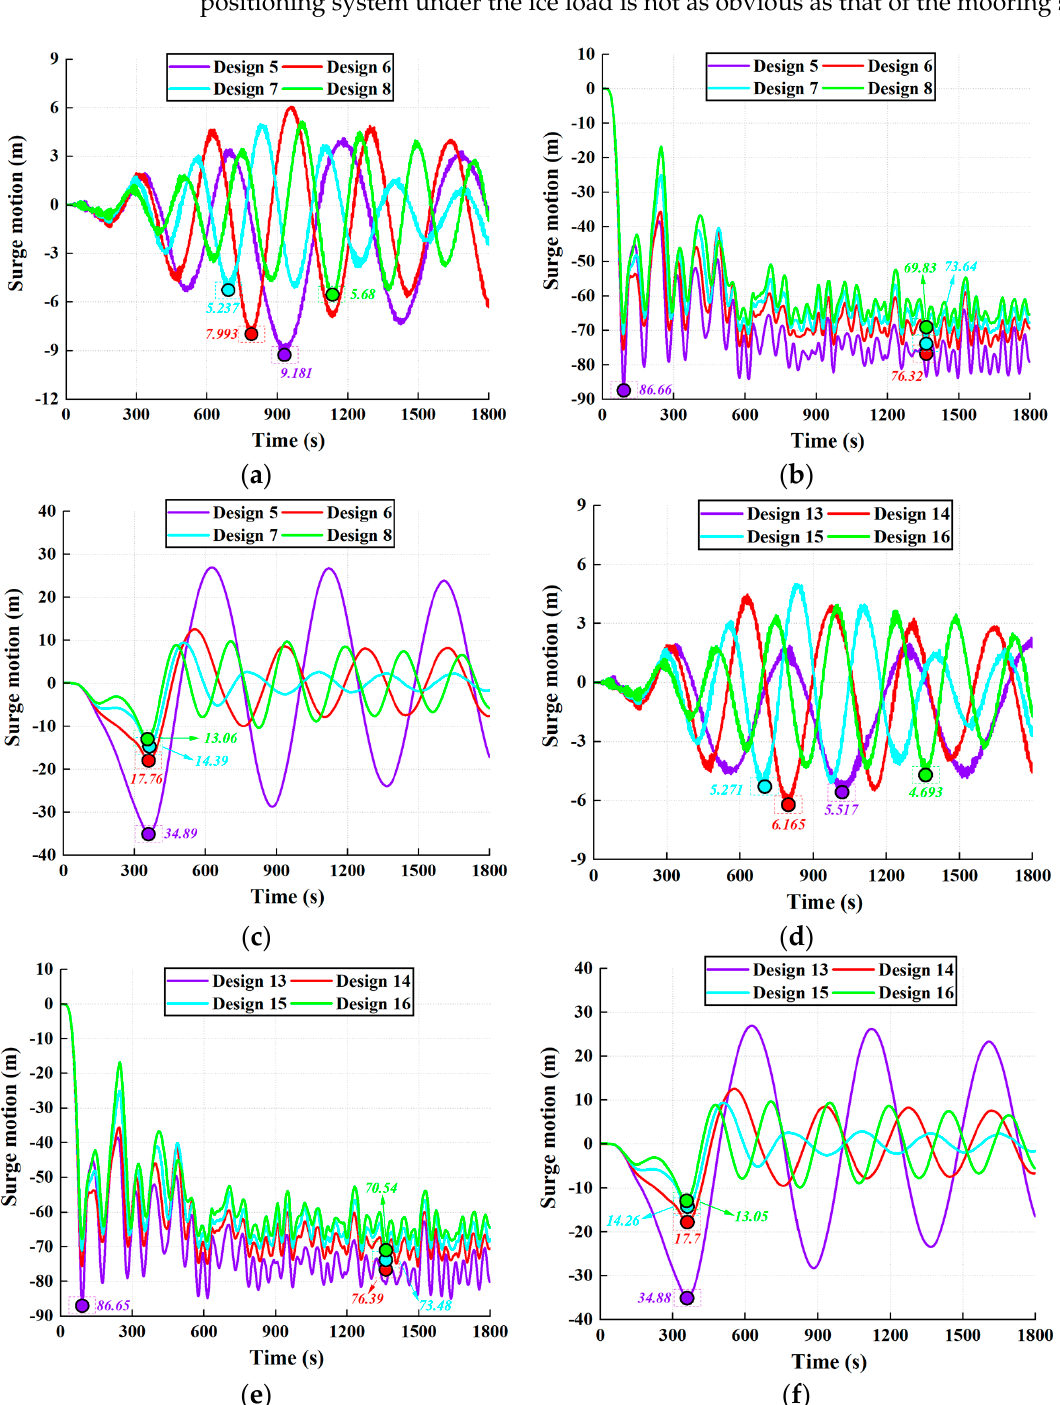
Figure 10. Surge motion of the platform under different environmental loads. ( a ) Surge motion in four-thrusters (Pattern 1) design under wave load; ( b ) Surge motion in four-thrusters (Pattern 1) design under level ice; ( c ) Surge motion in four-thrusters (Pattern 1) design under broken ice floes; ( d ) Surge motion in eight-thrusters design under wave load; ( e ) Surge motion in eight-thrusters design under level ice; ( f ) Surge motion in eight-thrusters design under broken ice floes.